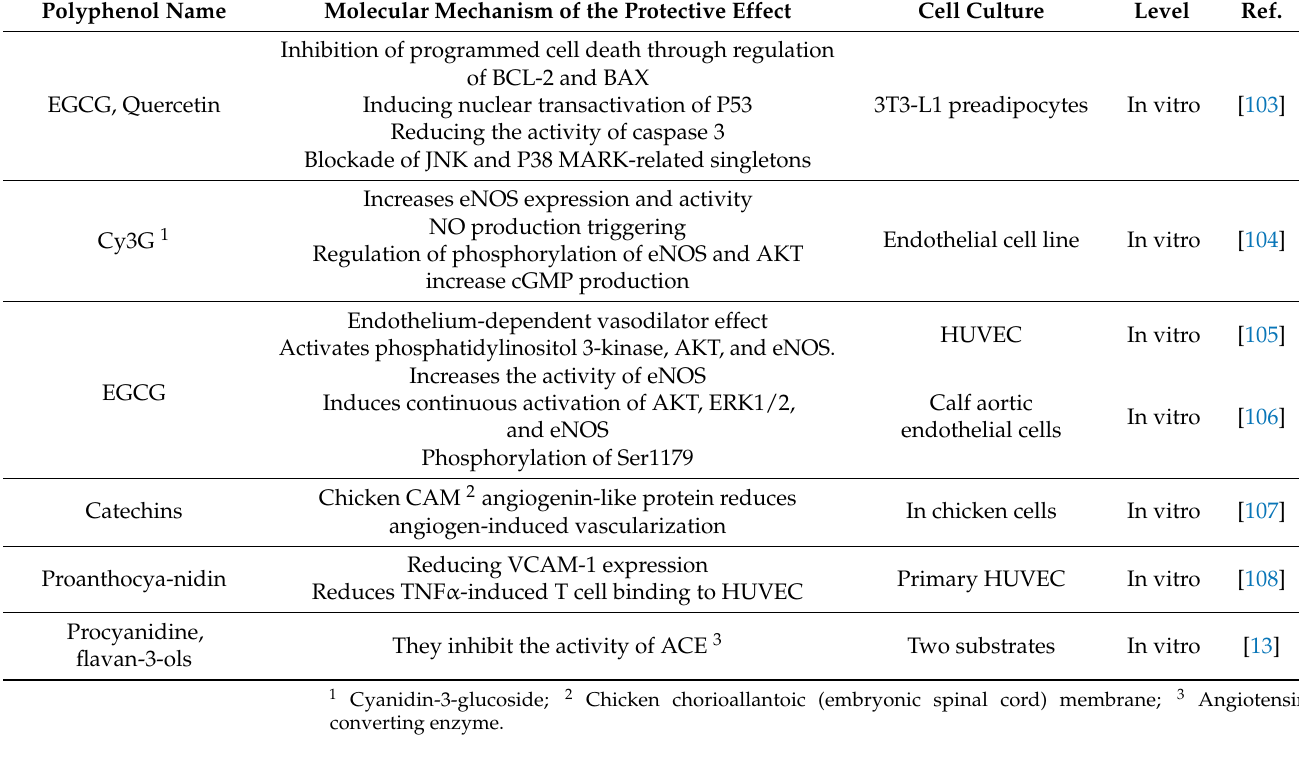
Table 11. Effect of the polyphenol content of grape marc (grape seeds and grape skins) on endothelial cells and blood vessel walls.